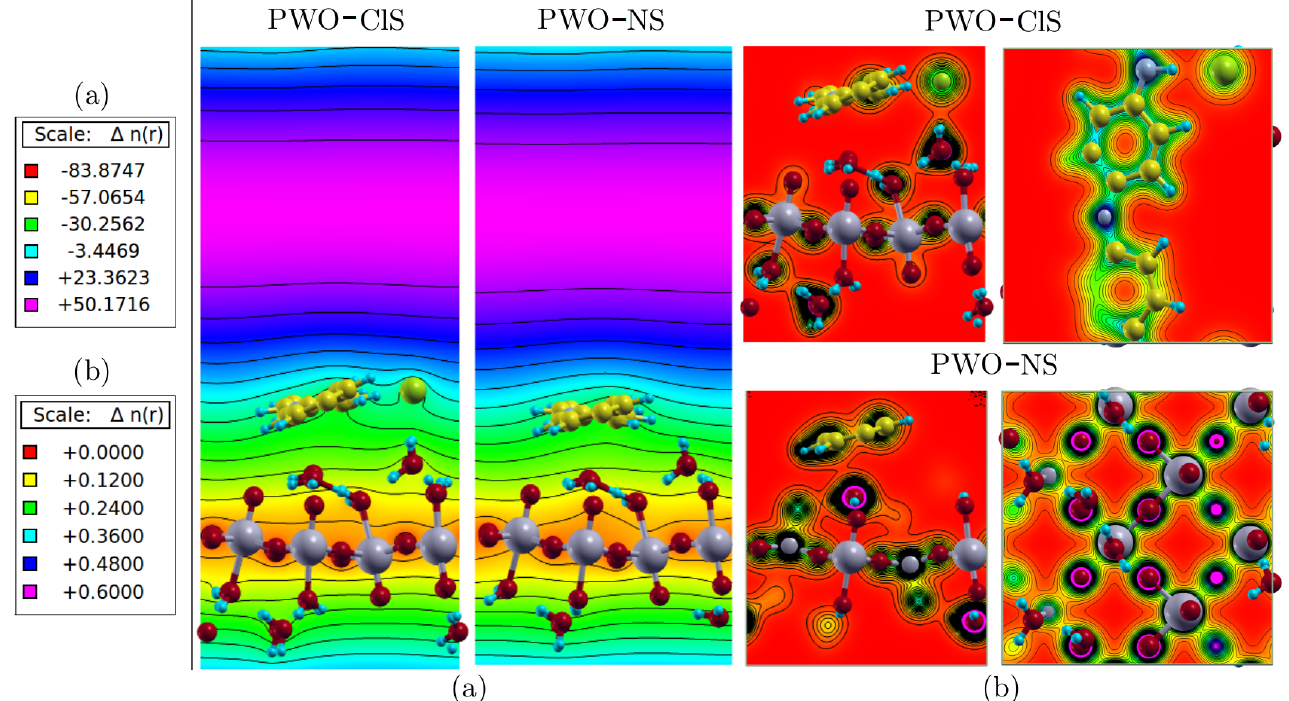
Figure 10. Ionic potential map and electric charge density on surface of the nanocomposite systems. ( a ) The scale of the ionic potential ranged from –83.87 (red) to +50.17 (purple) in a plane perpendicular to the growth of the polymer chain and ( b ) The scale of charge density ranging from 0 (red) to 0.6 (purple) in perpendicular and parallel directions to the z –axis, in which a higher distribution of charges was observed in the more electronegative atoms.